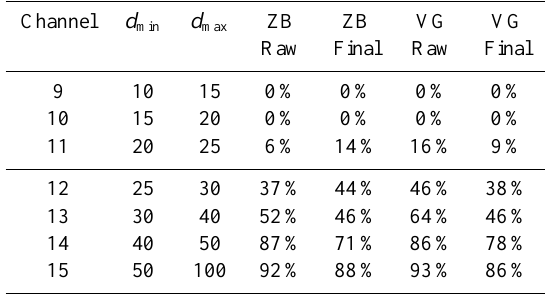
Table 1. Percentage of samples that recorded zero counts in the channels indicated.